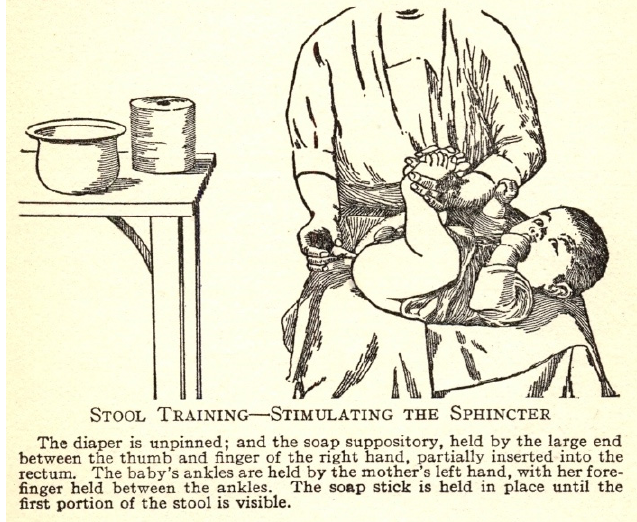
Figure 16. The Next Step in Early Bowel Training–Using the Soap Stick. Mothers were instructed to use the soap suppository if necessary to encourage a timely bowel movement.